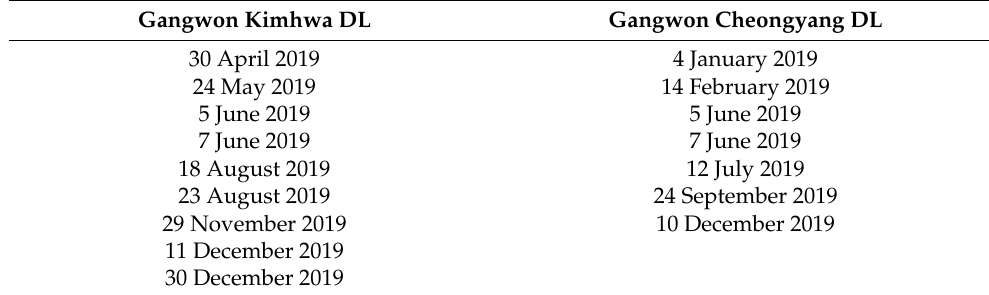
Table 3. History of actual load transfer event.